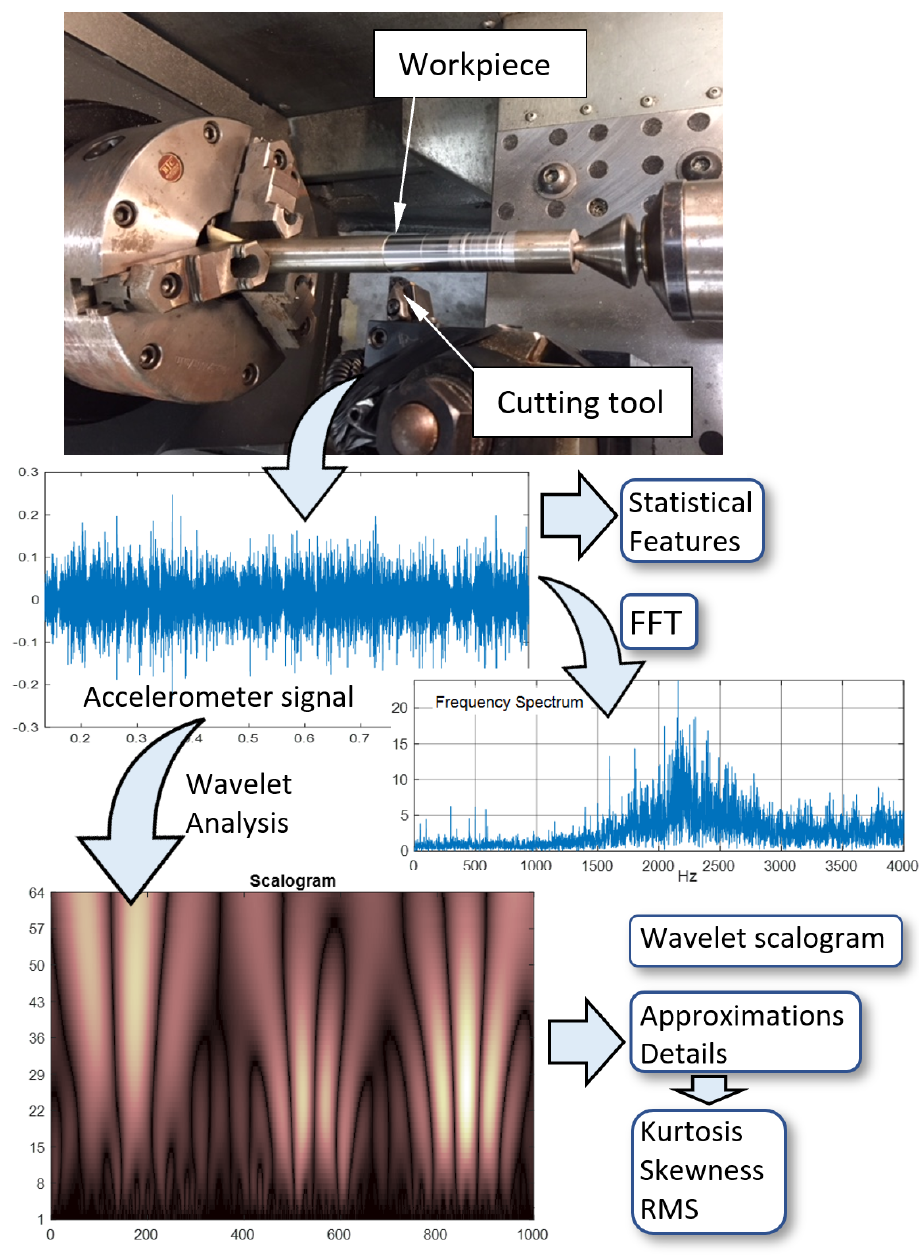
Figure 1. Turning test and vibration signal processing scheme.